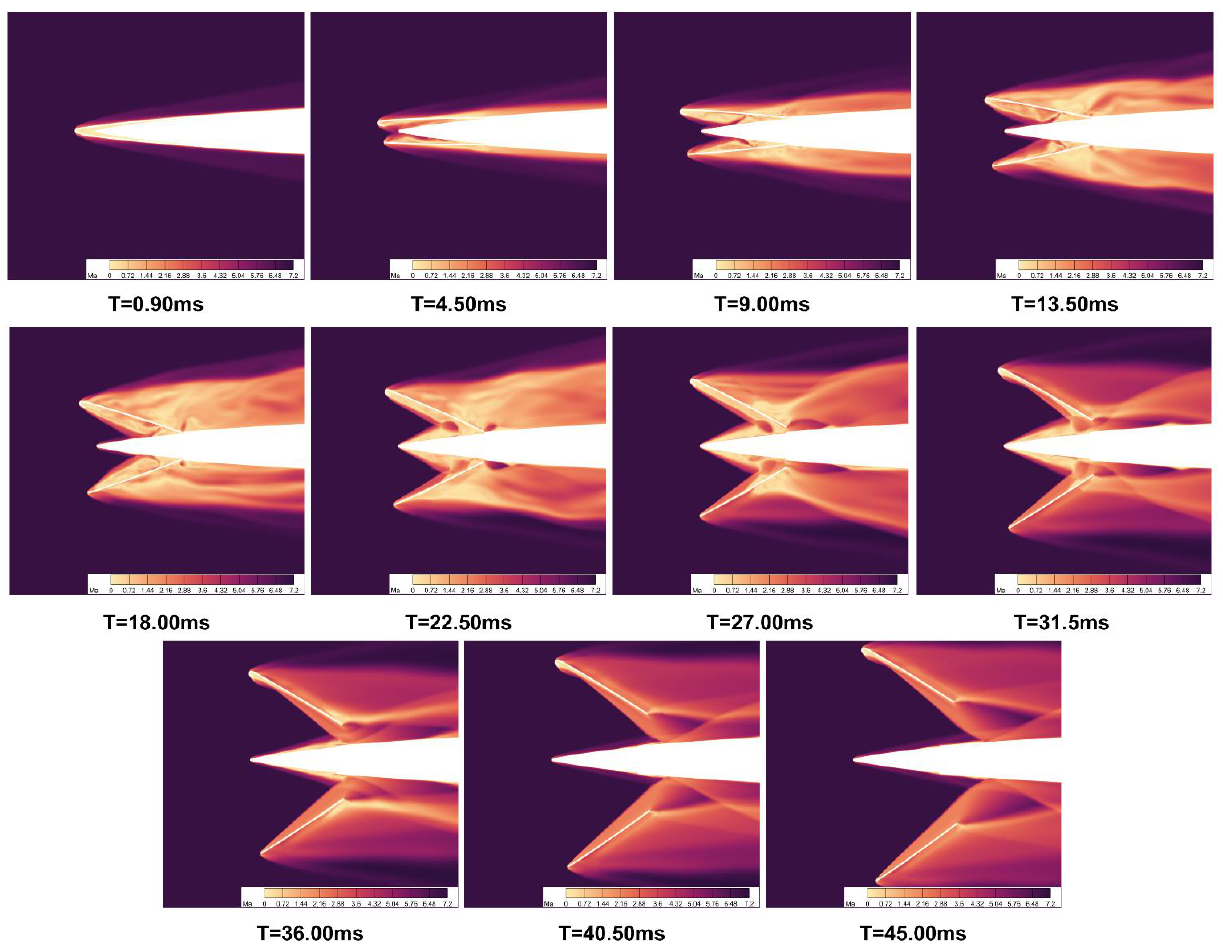
Figure 15. Multi-body separation characteristics of the shroud.